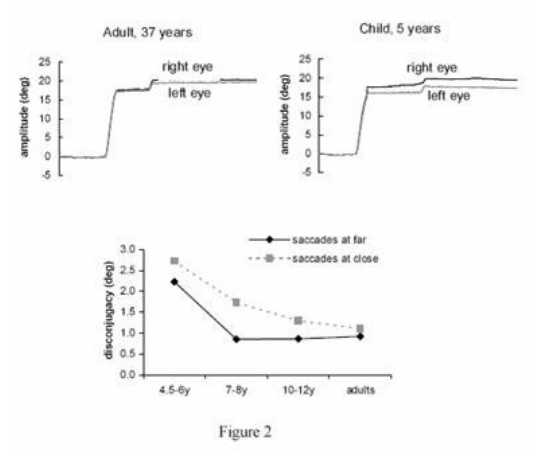
Figure 2. Up: Example of binocular recording of a rightward saccade from an adult and a child (5 years old). Bottom: Sac- cade disconjugacy for children as a function of their age. In the graph, adult data are shown on the right. The saccade discon- jugacy in children is dramatically deteriorated at close dis- tance, more than was the case for